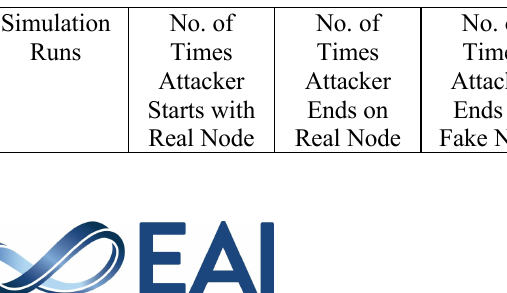
Table 3. Performance evaluation table for real to real and